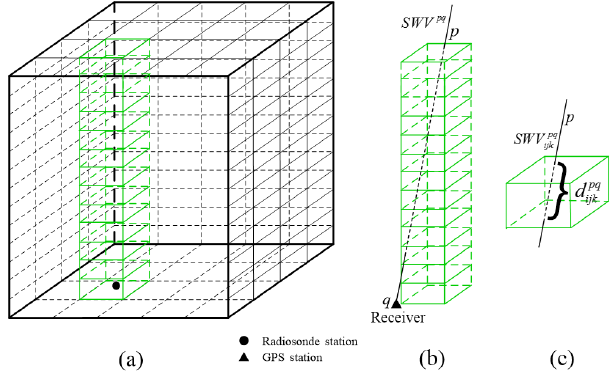
Figure 3. Voxel division in tomographic